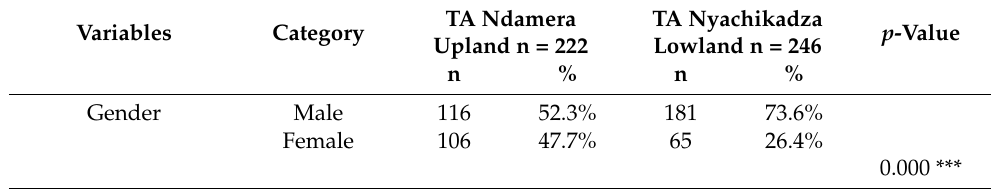
Table 1. Demographic and socioeconomic profile of study participants by traditional authority (TA or